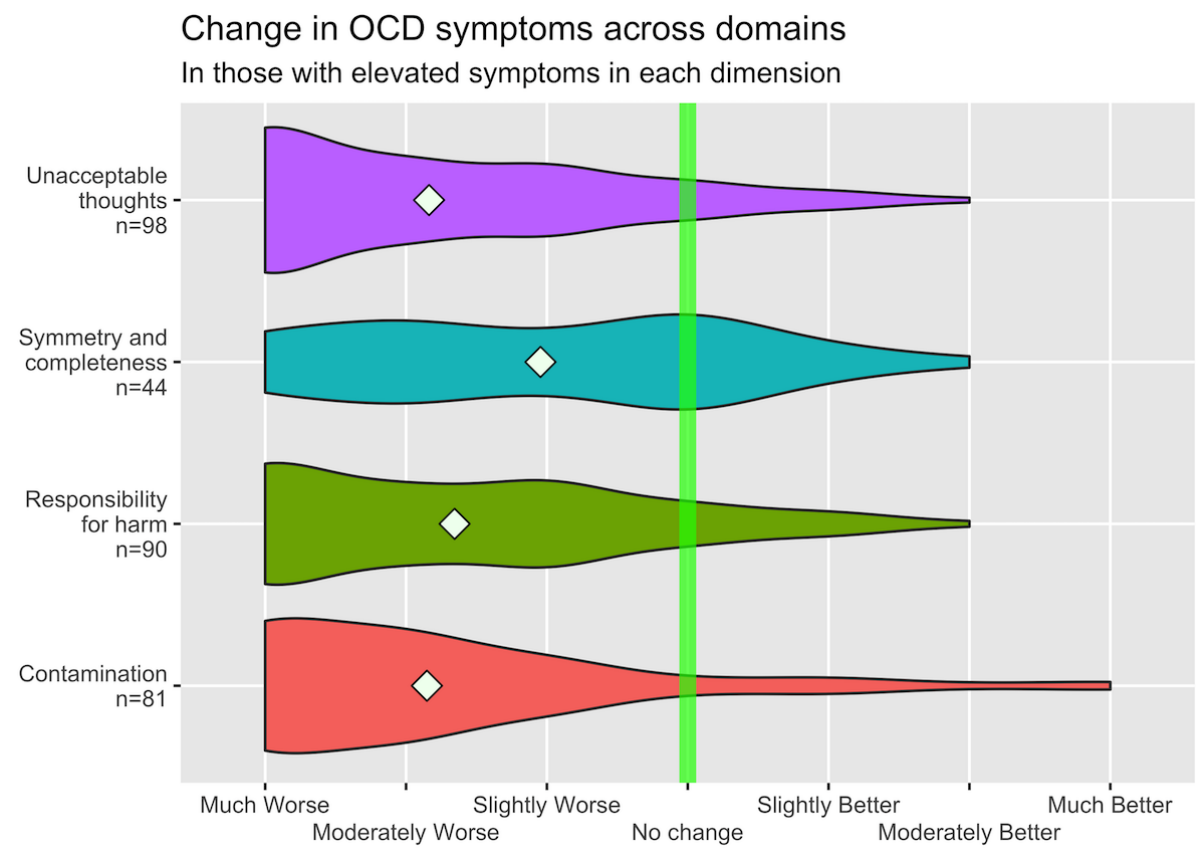
Figure 2. Changes in obsessive-compulsive disorder symptom severity across dimensions evaluated among only those participants with clinically elevated symptoms for a given dimension of obsessive-compulsive disorder, as defined by the Dimensional Obsessive-Compulsive Scale. We considered participants to have clinically elevated symptoms for a given symptom dimension if they scored an average score of 2 (range 0-4) across each item in that symptom dimension, which corresponds to moderate symptoms. White diamonds correspond to sample means. Participants indicated the extents to which their symptoms across the four dimensions of obsessive-compulsive disorder (“unacceptable thoughts,” “symmetry and completeness,” “responsibility for harm,” and “contamination”) had changed since the onset of the COVID-19 pandemic, with scores ranging from −3 (much worse) to 3 (much